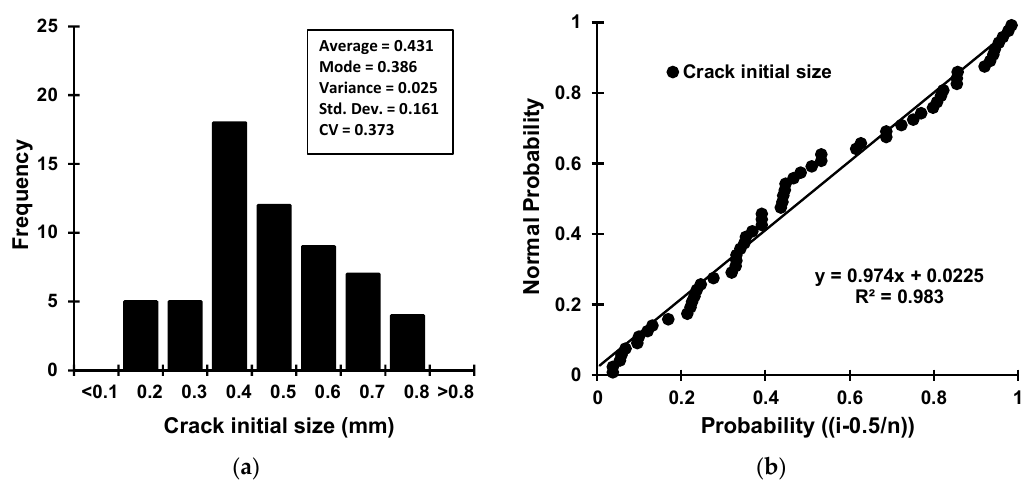
Figure 10. ( a ) Frequency histogram and statistical parameters of the crack initial size data; and ( b ) Normal probability-probability plot for the crack sizes.